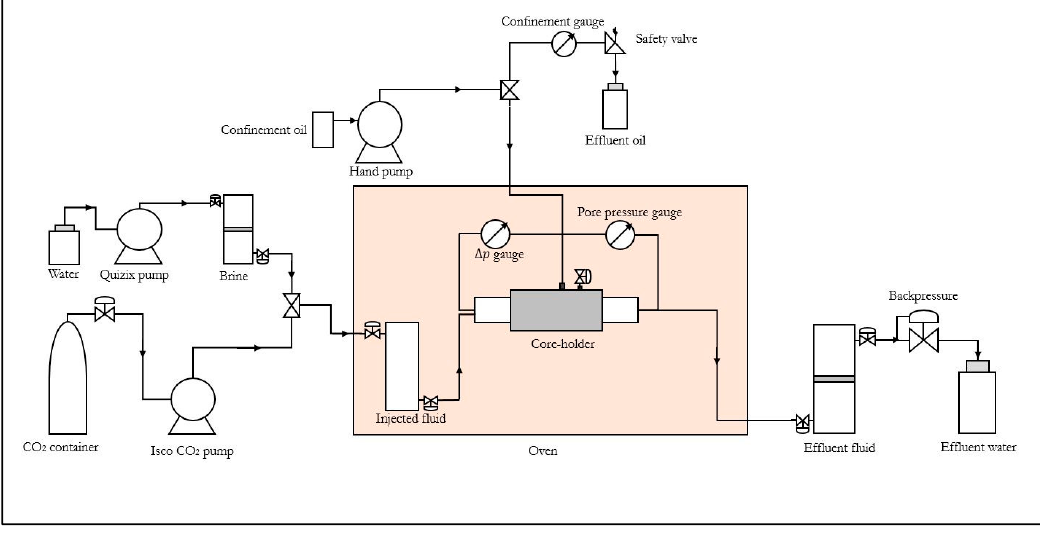
Figure 2 . Schematic of the experimental setup used in the core-flood experiments: the CO 2 flow